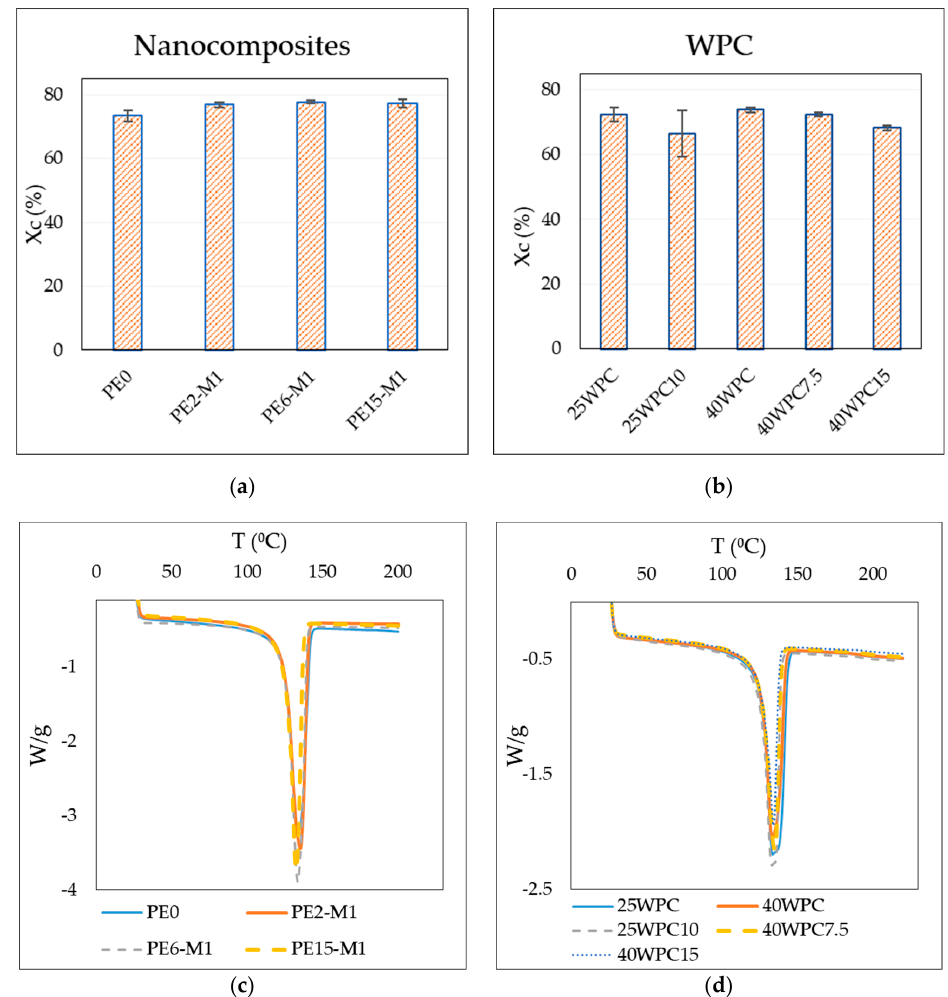
Figure 8. DSC results of the tested materials. It is worth noting that number of specimens tested was